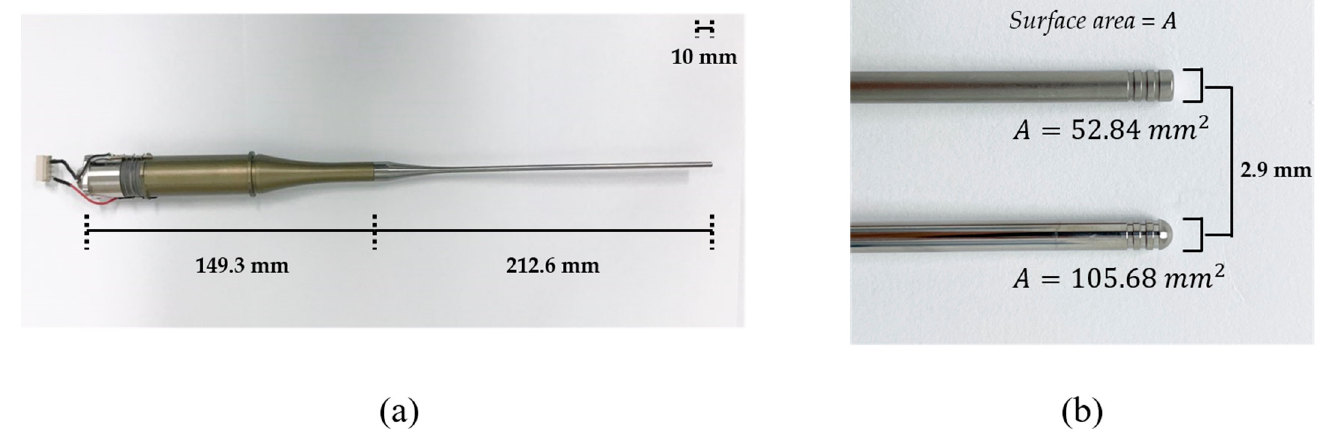
Figure 1. ( a ) Assembled Langevin transducer. ( b ) Tip shapes: ( top ) flat tip, ( bottom ) round tip.